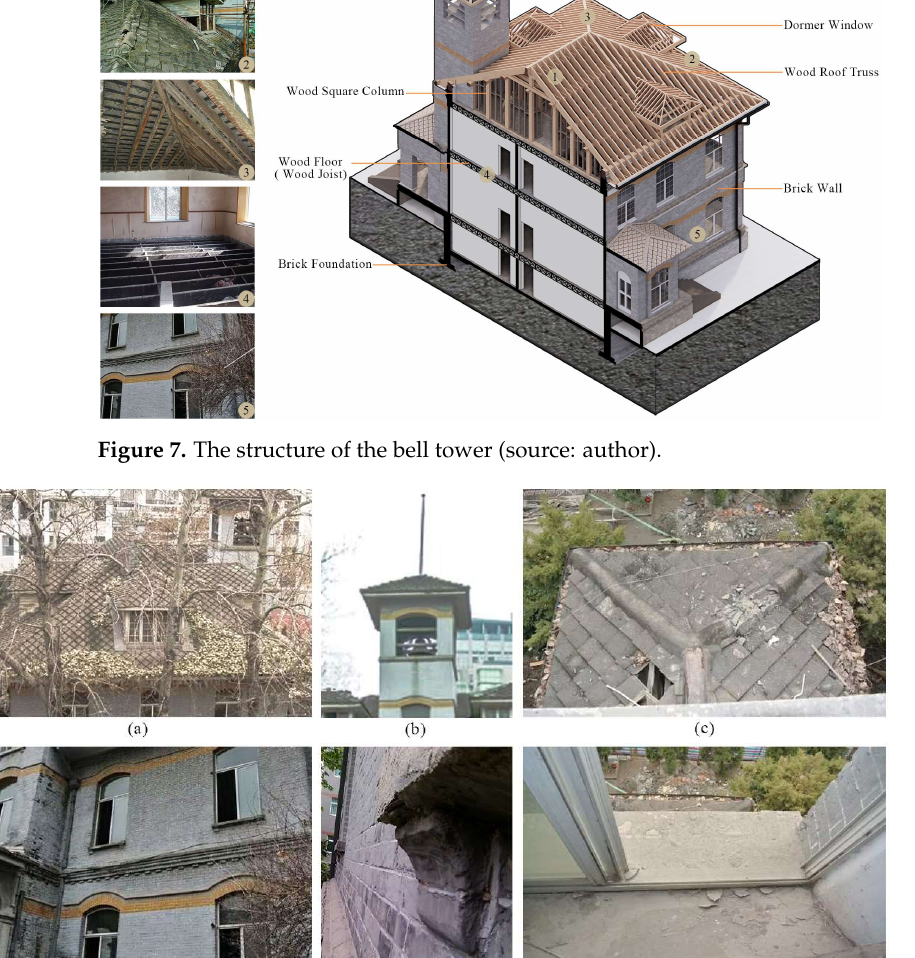
Figure 8. Damaged state of the bell tower(source: author). ( a ) Damaged roof ( b ) Damaged tower walls ( c ) Broken tile ( d ) Broken south wall ( e ) Broken wall detail ( f ) Broken window and window sill